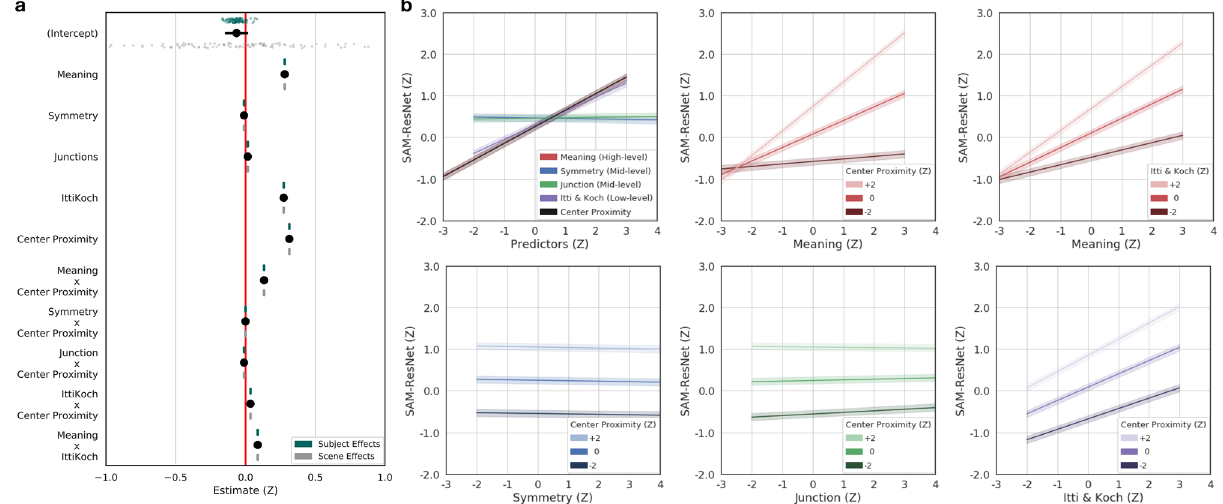
Figure 5. SAM-ResNet LME model, marginal effects, and interactions. ( a ) Fixated SAM-ResNet values as a function of low-, mid-, and high-level features and interactions. The black dots with lines show the fixed effect estimates and their 95% confidence intervals. Subject (green dots) and scene (grey dots) were both accounted for in the model as random intercepts. ( b ) Line plots of all model marginal effects and all model interactions. All error bands reflect 95% confidence intervals.